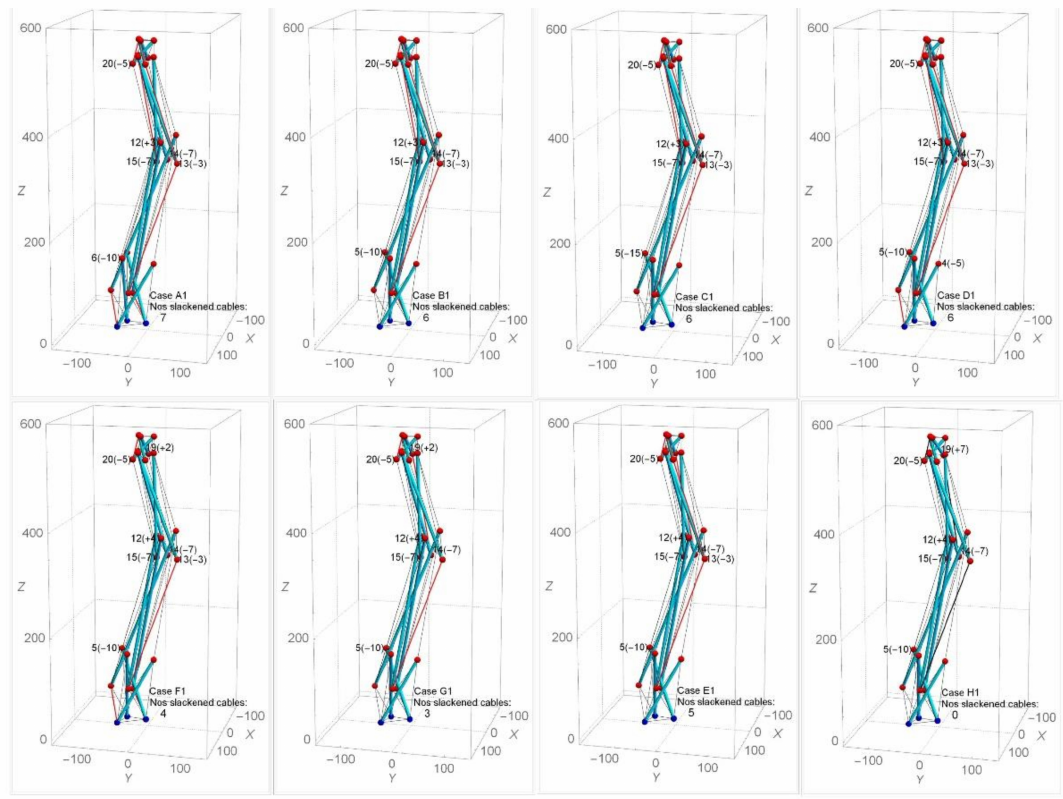
Figure 14. E ff ect of di ff erent modifications of nodal coordinates on the number of slackened cables in